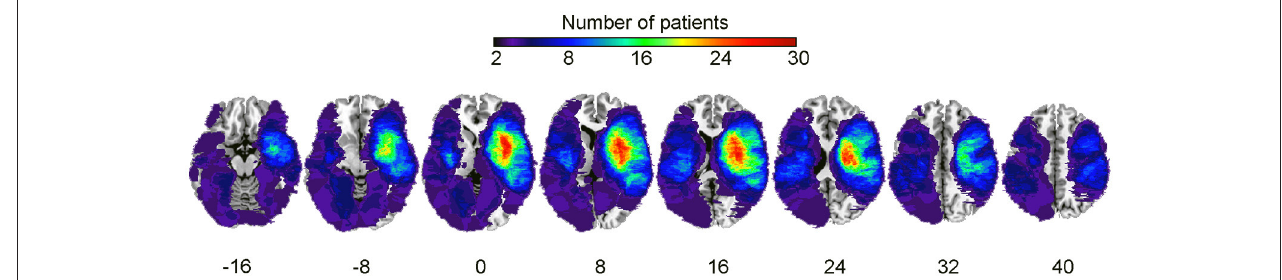
FIGURE 1 | Lesion overlap map summing all subjects. Lesion distribution for the whole sample ( N = 90). The warmer the areas, the greater the lesion overlap. Accordingly, the color scale ranges from 2 to 30 overlapping subjects.